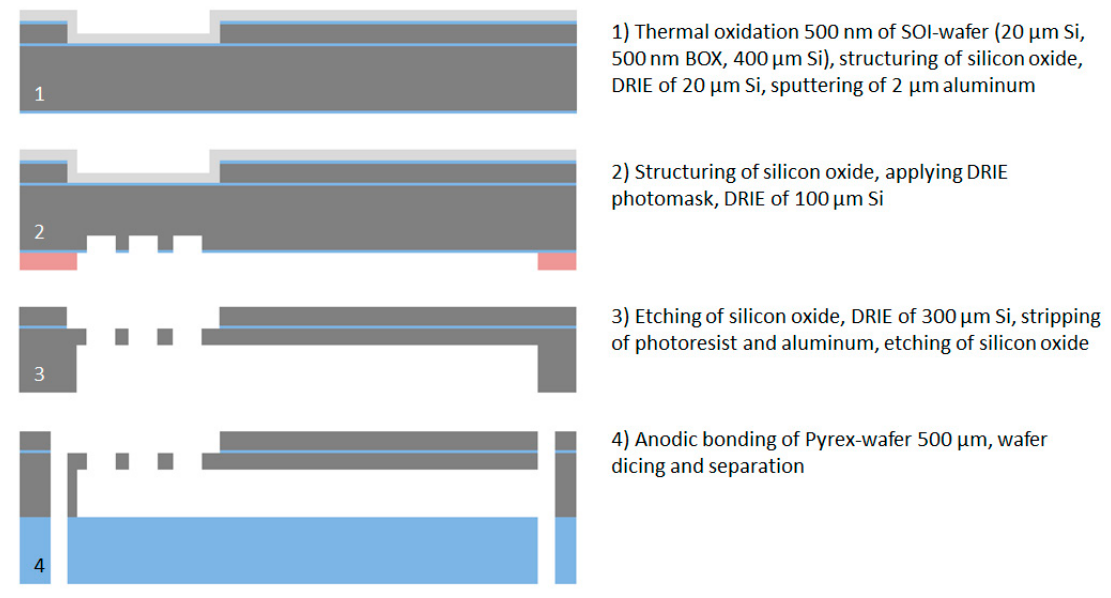
Figure 6. Cross section view of the microfabrication process flow for the vacuum-actuated insertion tool.